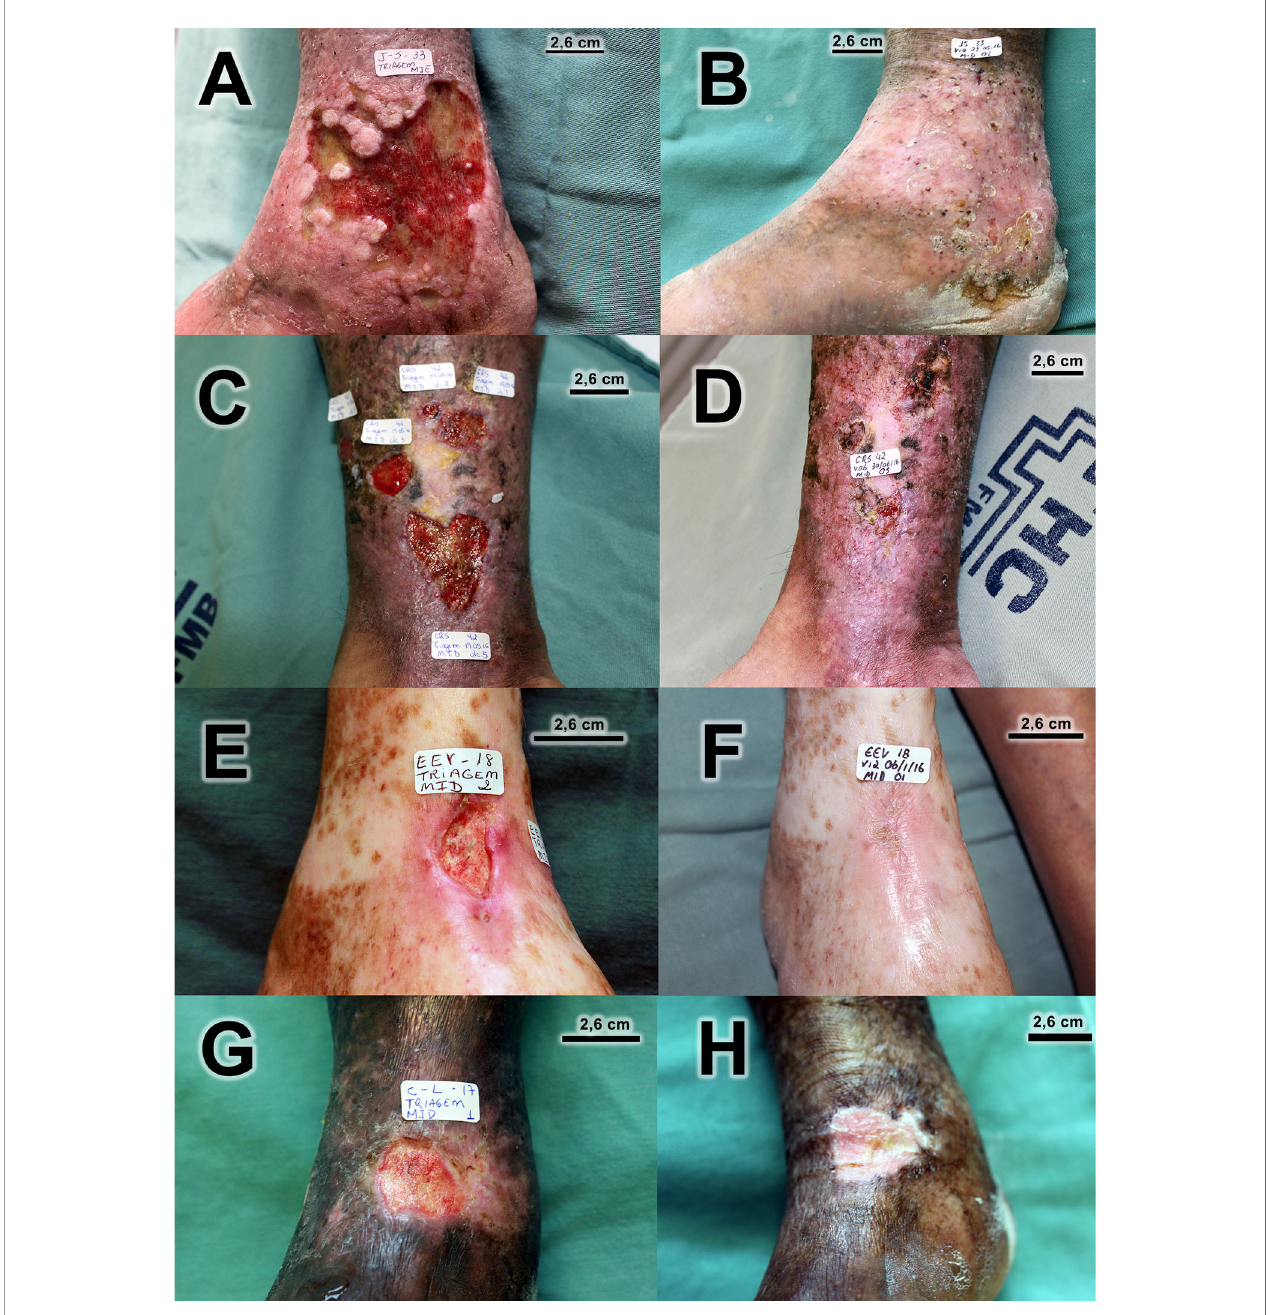
FIGURE 5 | Photographic records of venous ulcers of some participants who have a good evolution of the healing process. (A) Before treatment (ulcer area 51,83 cm 2 )/ (B) Complete healing at visit 10. (C) Before treatment (total ulcer area 19.67 cm 2 )/ (D) Only one ulcer did not heal completely at fi nal visit. (E) Before treatment (ulcer area 3.48 cm 2 )/ (F) Complete healing at fi nal visit. (G) Before treatment (ulcer area 4.89 cm 2 )/ (H) Complete healing at visit